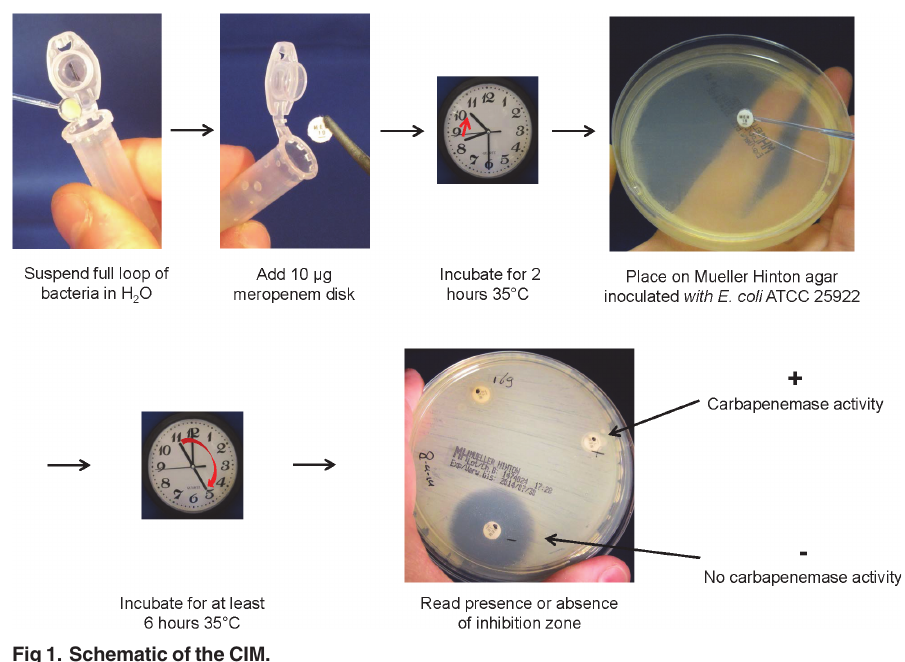
Fig 1. Schematic of the